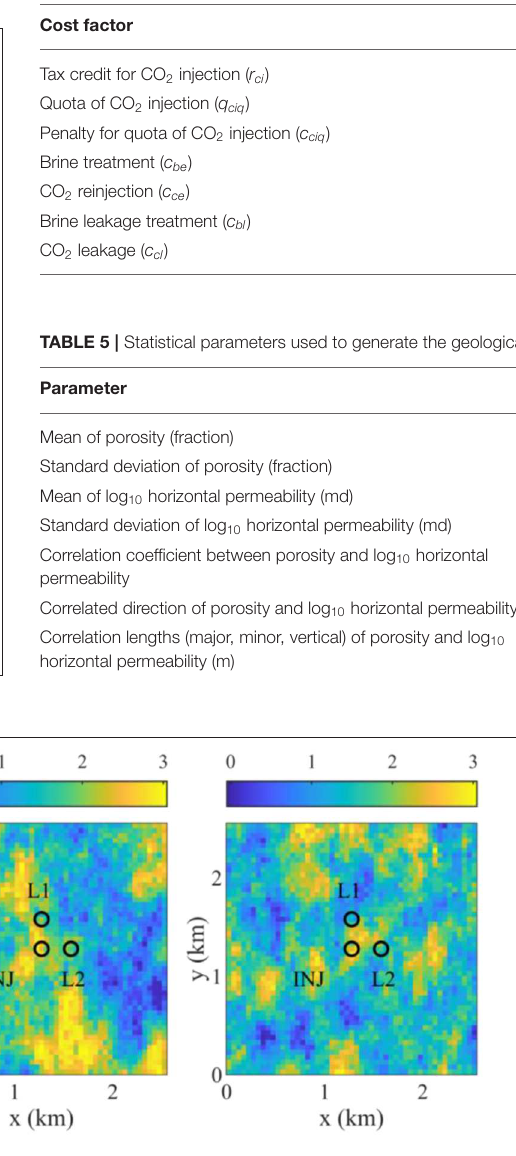
Frontiers in Earth Science |